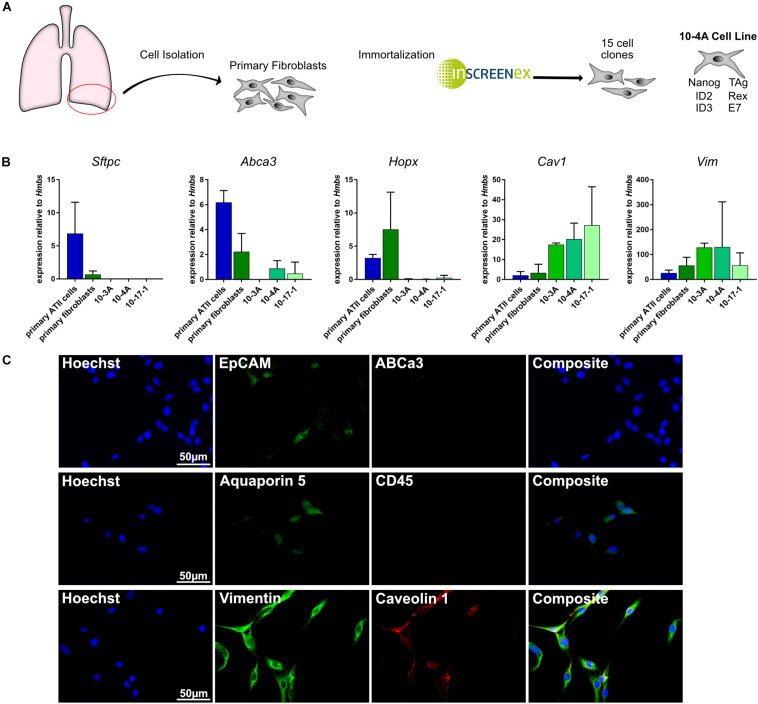
Gene and protein expression pattern of the immortalized cell lines. (A) Schematic representation of the immortalization process. Right: Genes incorporated in 10-4A cells for immortalization (B) Semi-quantitative RT-PCR of ATII cell (Sftpc, Abca3), ATI cell (Hopx, Cav1), and mesenchymal cell (Vim) marker genes. N = 5 (C) Immunofluorescent staining of 10-4A cells for expression of epithelial cell (EpCAM), alveolar type II cell (ABCa3), alveolar type I cell (aquaporin 5, caveolin 1), leukocyte (CD45), and mesenchymal cell (vimentin) marker expression. 10-4A cells predominantly express mesenchymal marker vimentin and caveolin-1, that is also expressed in lung fibroblasts. Scale bar = 50 μm.